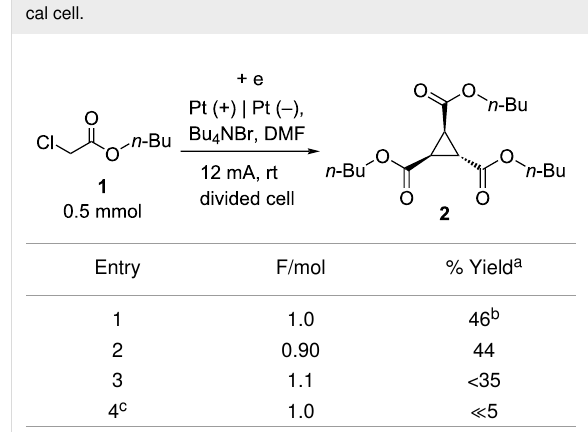
Entry Variation from standard conditions a